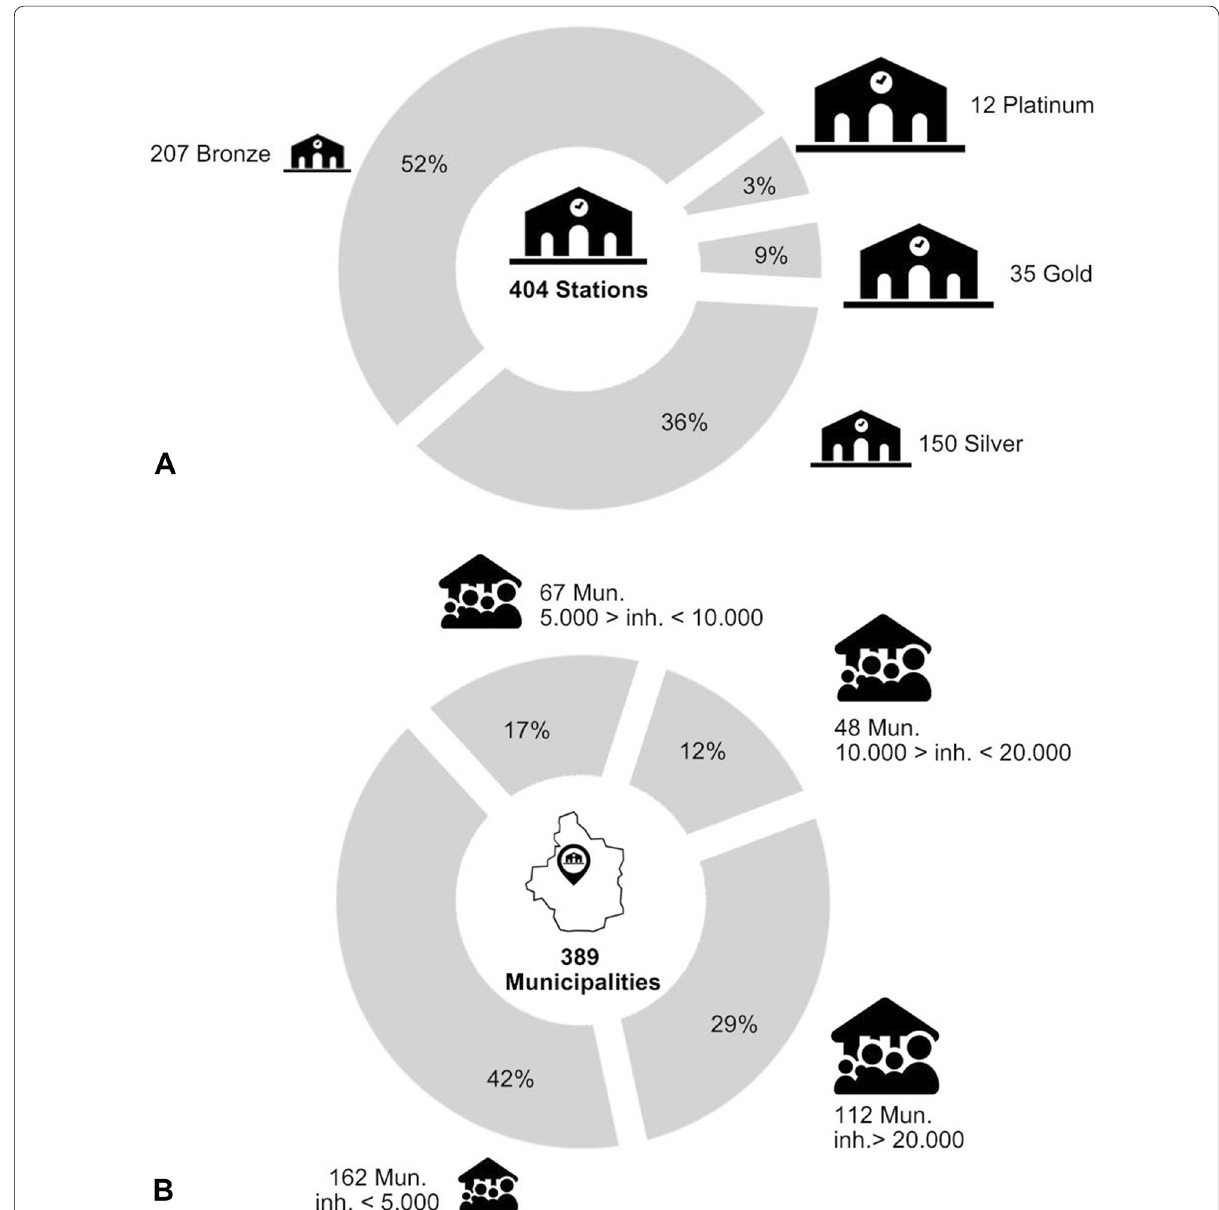
Fig. 14 Typology of stations ( a ) and Municipalities ( b ) on the railway in proximity of EuroVelo paths in